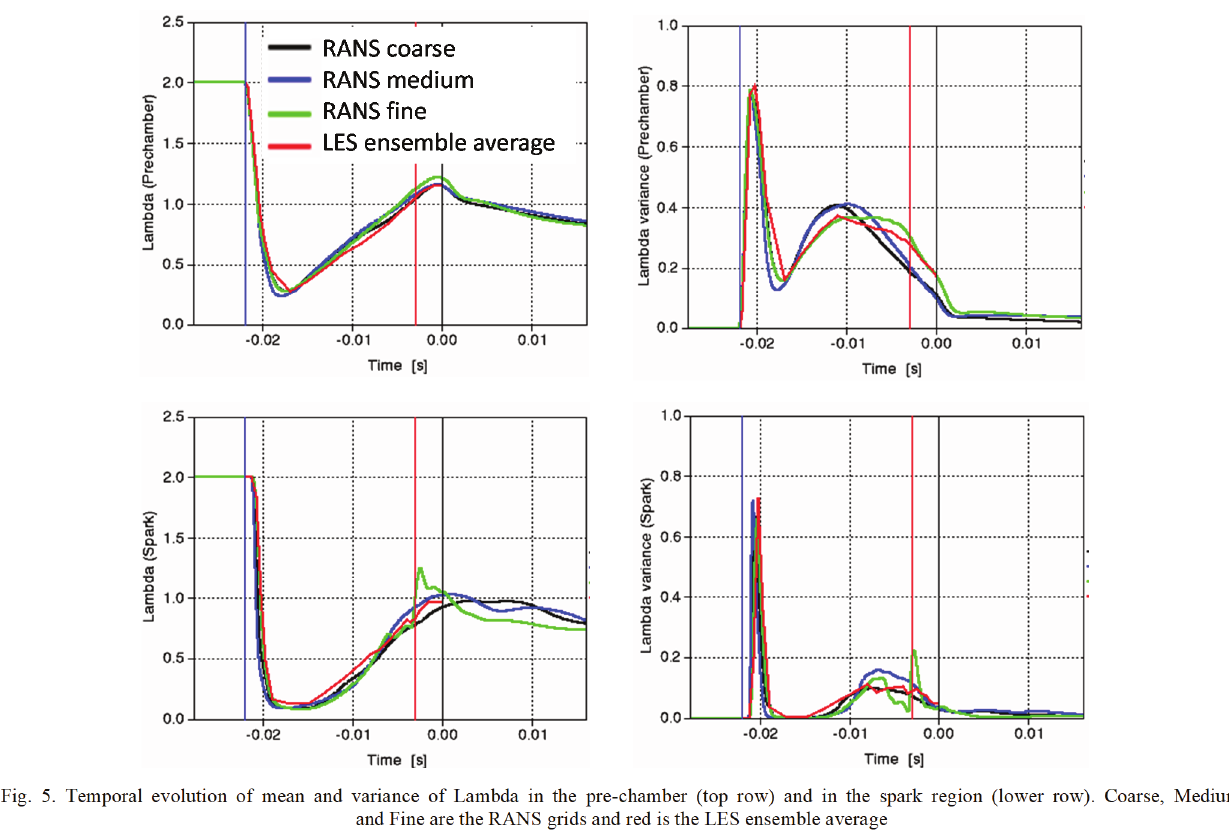
Fig. 5. Temporal evolution of mean and variance of Lambda in the pre-chamber (top row) and in the spark region (lower row). Coarse, Medium and Fine are the RANS grids and red is the LES ensemble average CH4 mass fraction